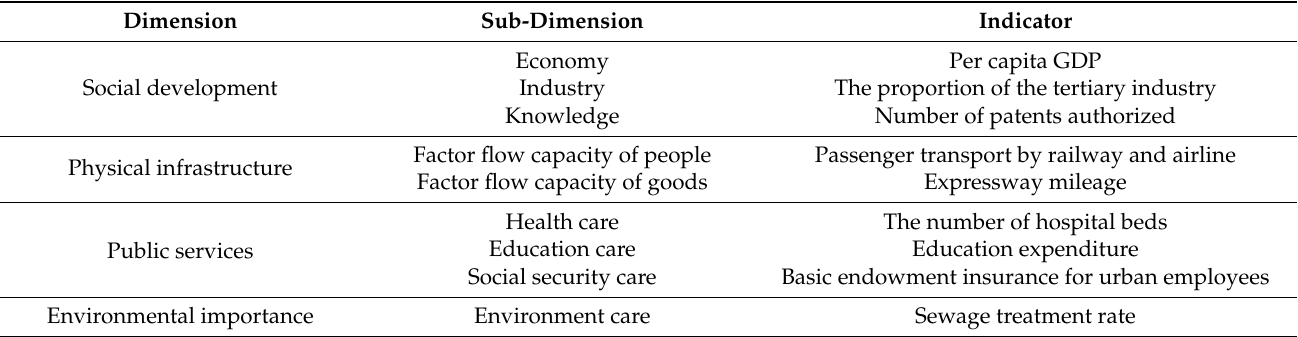
Table 1. Index system to construct city